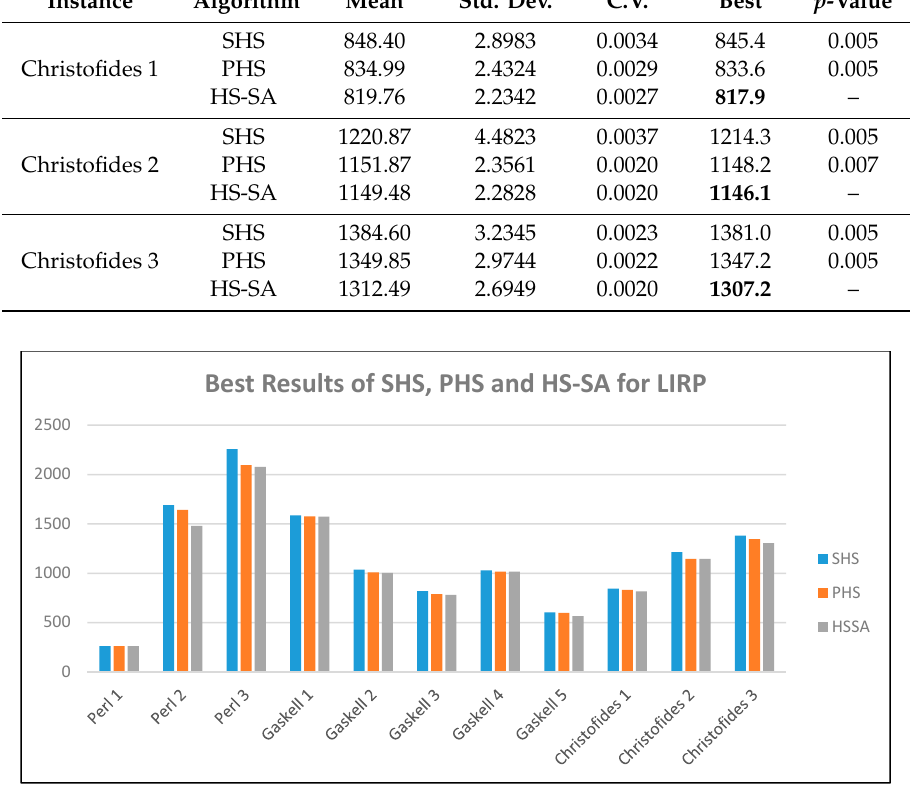
Figure 6. Best result of Perl, Gaskell, and Christofides dataset in LIRP for SHS, PHS, and HS-SA.